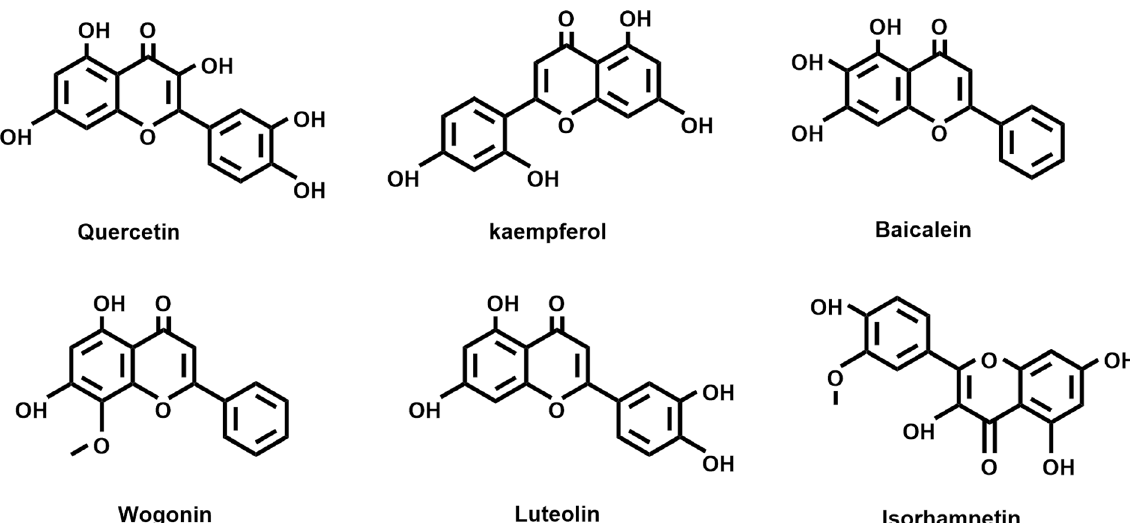
Figure 4. Chemical structures of the 6 core active